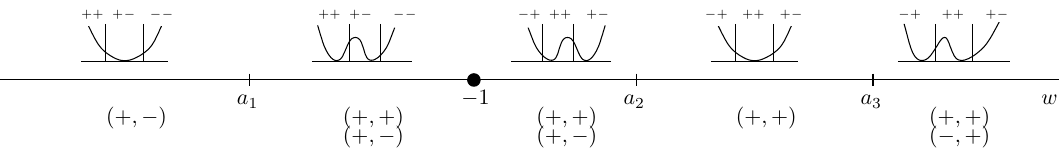
Figure 24. The Landau-Ginzburg potential U e(cid:11) ( (cid:27) ) plotted for w (horizontal line in this graph) ranging from (cid:0)1 to 1 , in the case that sgn( (cid:22) ) = sgn( (cid:21) ). One of the two vertical lines in each plot of U e(cid:11) ( (cid:27) ) | the line that separates a bosonic (second index) + phase from a bosonic (cid:0) phase | lies at (cid:27) = 0. The second vertical line separates the fermionic ((cid:12)rst index) + phase from the 1 fermionic (cid:0) phase and lies at (cid:27) = (cid:0) (cid:22) and occurs at either positive or negative values of (cid:27) (cid:21) 1+ w depending on the value of w . The brackets below the horizontal line denote the phase(s) of the theory for the appropriate ranges of w . The quantities a 1 , a 2 and a 3 are de(cid:12)ned in (5.10) and are given by a 1 = a (cid:0) 1 = (cid:0) 2 (cid:0)j (cid:21) , a 3 = 2+ j (cid:21) j . 2 j (cid:21) j j (cid:21) j